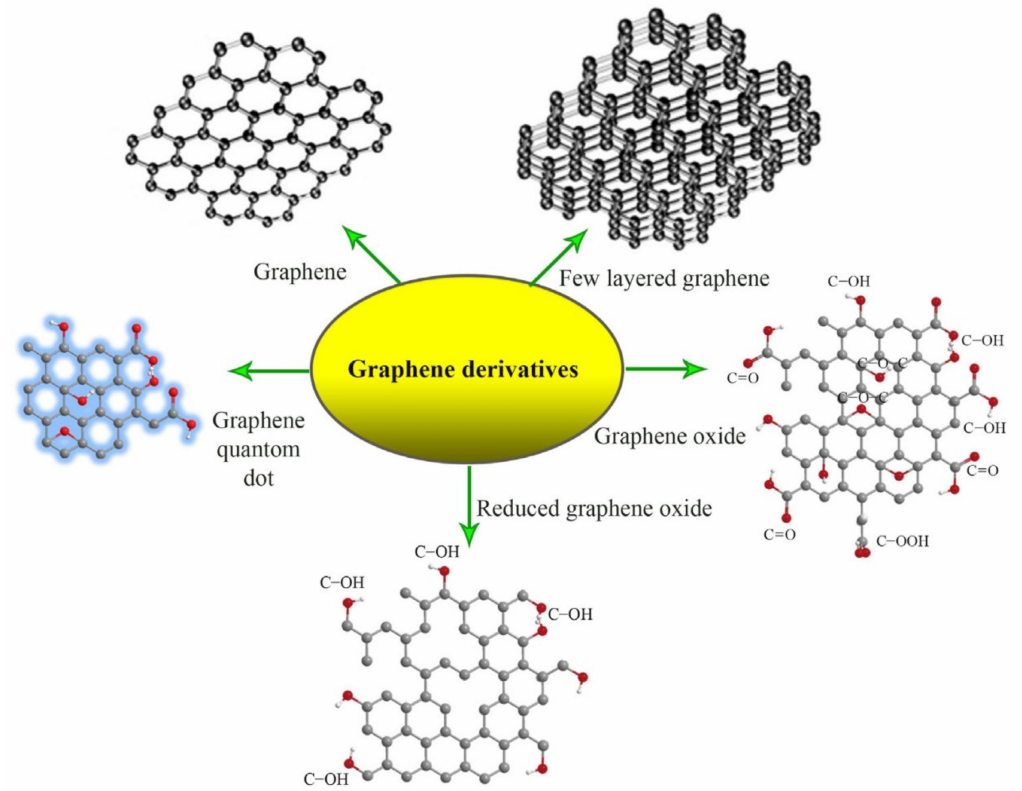
Figure 1. The chemical structures of graphene and its derivatives [46]. Reproduced with copyright